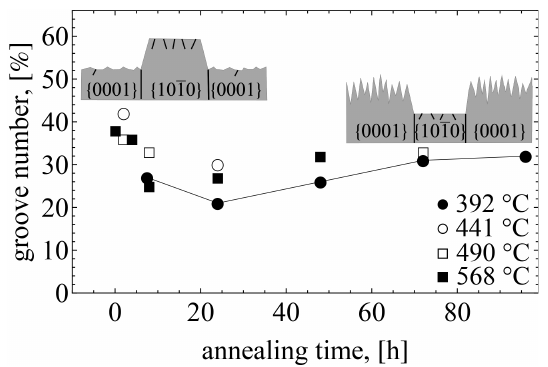
Figure 8. Observed frequency of step height normalized by groove depth after annealing at 392 ◦ C and ∼ 200MPa for indicated dura- tions ( N indicates the number of